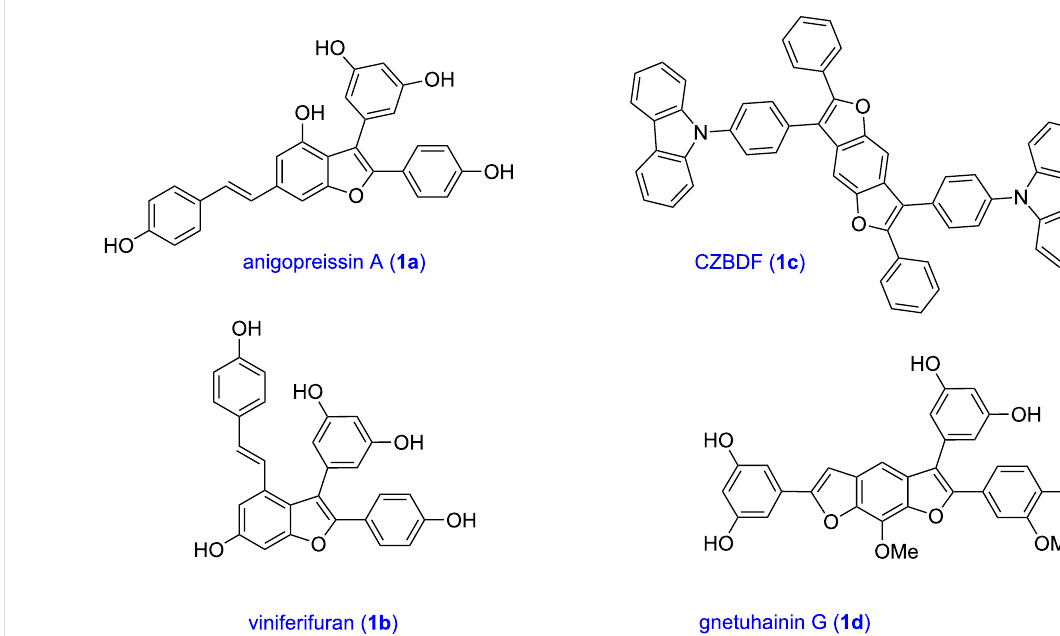
Figure 1: Important benzofuran skeletons.